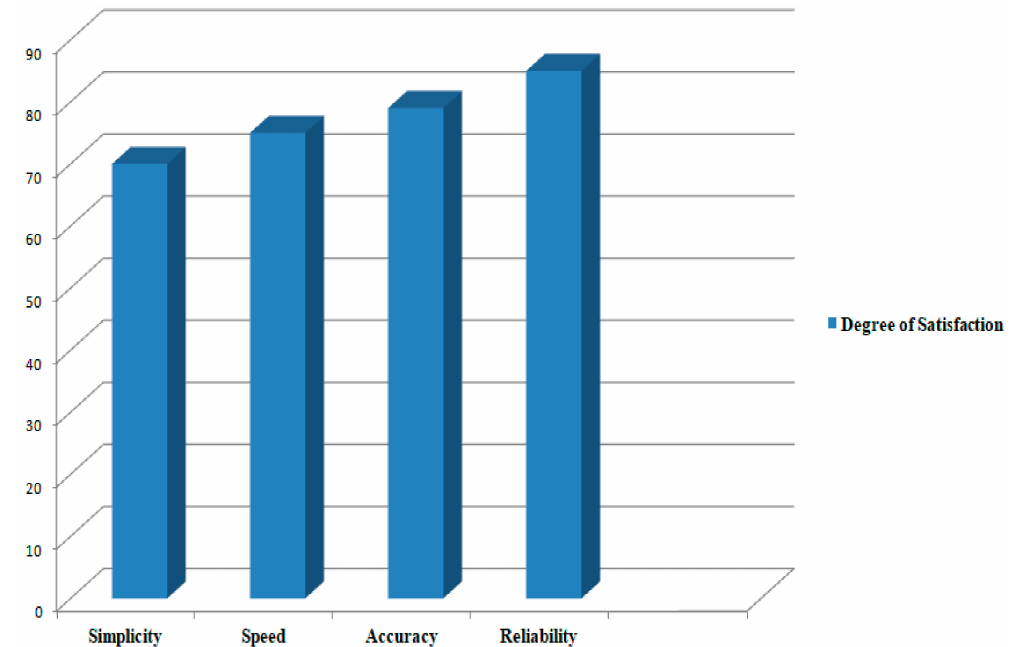
Figure 12. Evaluation of the hybrid intelligent